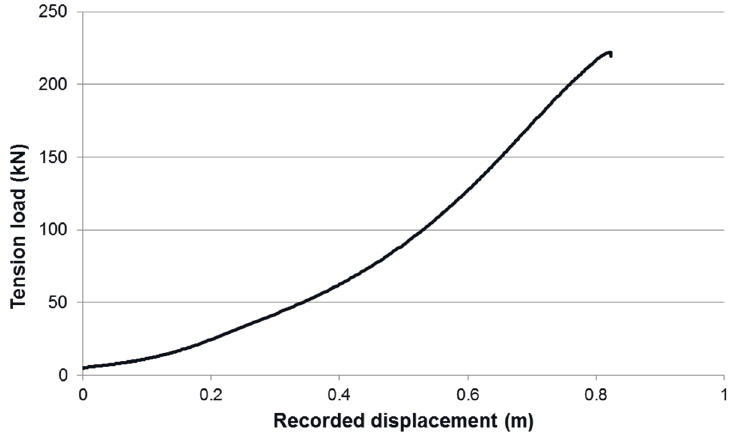
Figure 9. Load/displacement graph showing failure of P1-17 at 222 kN.